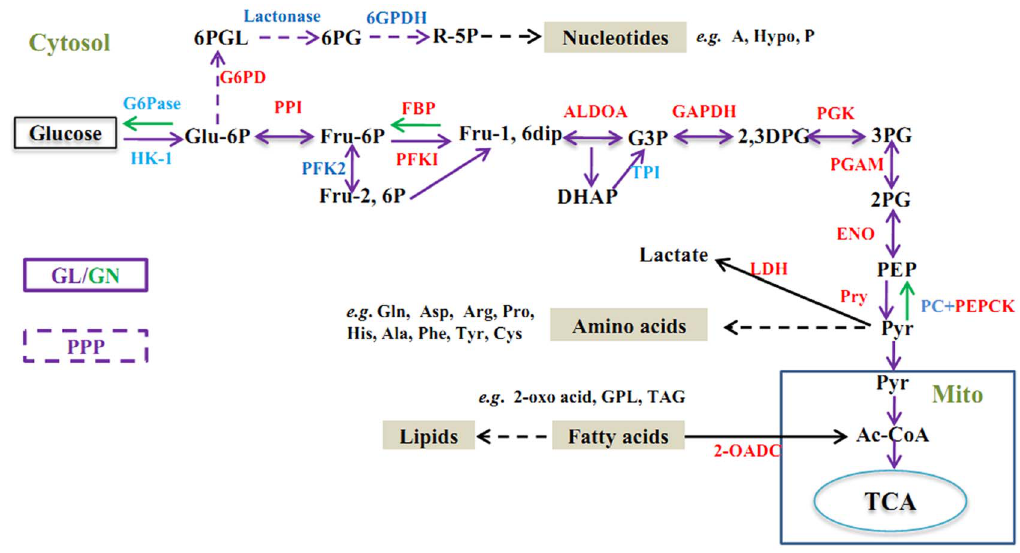
Fig. 1. Schematic diagram showing the carbohydrate metabolic pathways involved in the ESPs of Eg PSCs transcriptome (Reference from Eisenreich W et al. [19] with some modifications). Glycolysis (GL, purple arrows) and gluconeogenesis (GN, grass green arrows); pentose- phosphate pathway (PPP, broken purple arrows); tricarboxylic acid cycle (TCA, blue circle) other catabolic reactions that occur in the mitochondrion and in the cytosol (black arrows). Anabolic reactions leading to amino acids, nucleotides, and lipids are indicated by broken thick black arrows. Metabolites are marked in black. Enzymes identified in our study are marked in red, while other enzymes are marked in blue. Abbreviations: HK, hexokinase; PFK, phosphofructokinase; FBP, fructose bisphosphatase; PK, pyruvate kinase; PDH, pyruvate dehydrogenase complex; PCK, PEP- carboxylase; PPI, phosphohexose isomerase; TPI, triose phosphate isomerase; PGK, phosphoglycerate kinase; GAPDH, glyceraldehydes 3-phosphate dehydrogenase; PC, pyruvate carboxylase; LDH, lactate dehydrogenase; PEPCK, phosphoenol pyruvate carboxykinase; G6PD, glucose-6-phosphate dehydrogenase; ALDOA, fructose-biphosphate aldolase; PGK, phosphoglycerate kinase; PGAM, phosphoglycerate mutase; ENO, enolase; G6Pase, glucose 6-phosphatase; G6PD, glucose-6-phosphate dehydrogenase; 6GPDH, 6 -phosphogluconatedehydrogenase. Gln, Glutanine; Asp, aspartic acid; Arg, arginine; Pro, proline; His, histidine; Ala, alanine; Tyr, tyrosine; Cys, cysteine; Ade, adenine; Hyp, hypoxanthine.